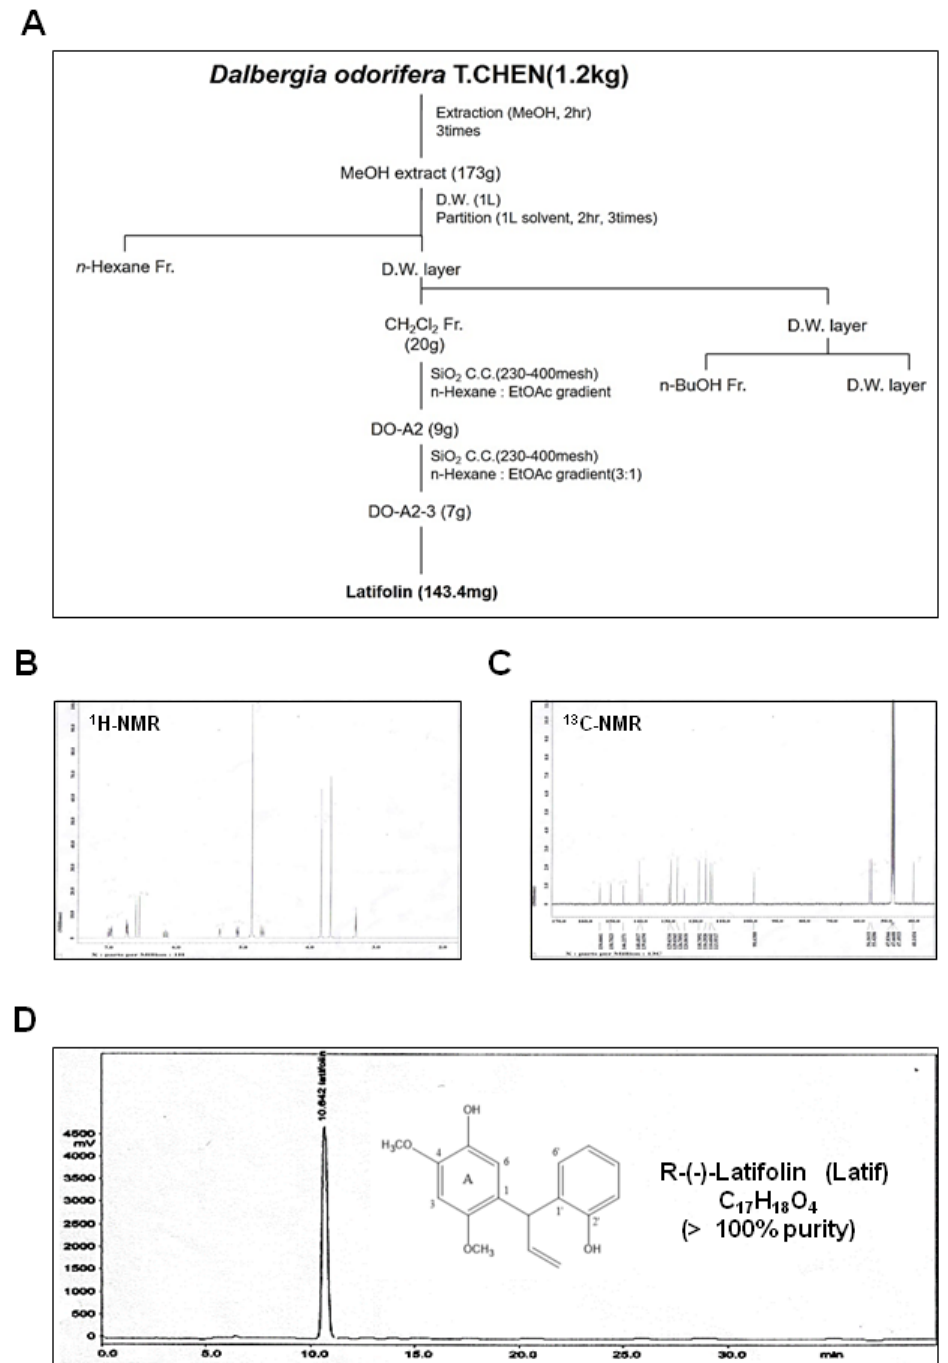
Figure 1. Isolation of Latif from the heartwood of D. odorifera . ( A ) Scheme of Latif isolated from the heartwood of D. odorifera . ( B , C ) The 1 H-NMR (500 MHz, CD 3 OD) spectrum ( B ) and 13 C-NMR (125 MHz, CD 3 OD) spectrum ( C ) of Latif. ( D ) The HPLC and chemical structure (inset) of Latif.